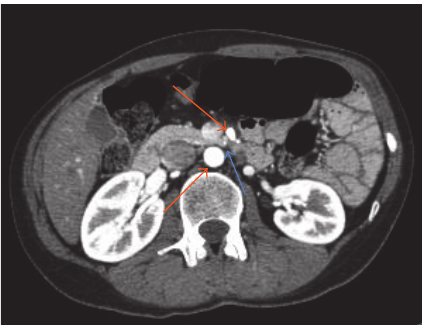
Figure 2: CT scan (axial view) with duodenal compression (blue arrow) between the aorta and superior mesenteric artery (orange arrows) (Case Report One).